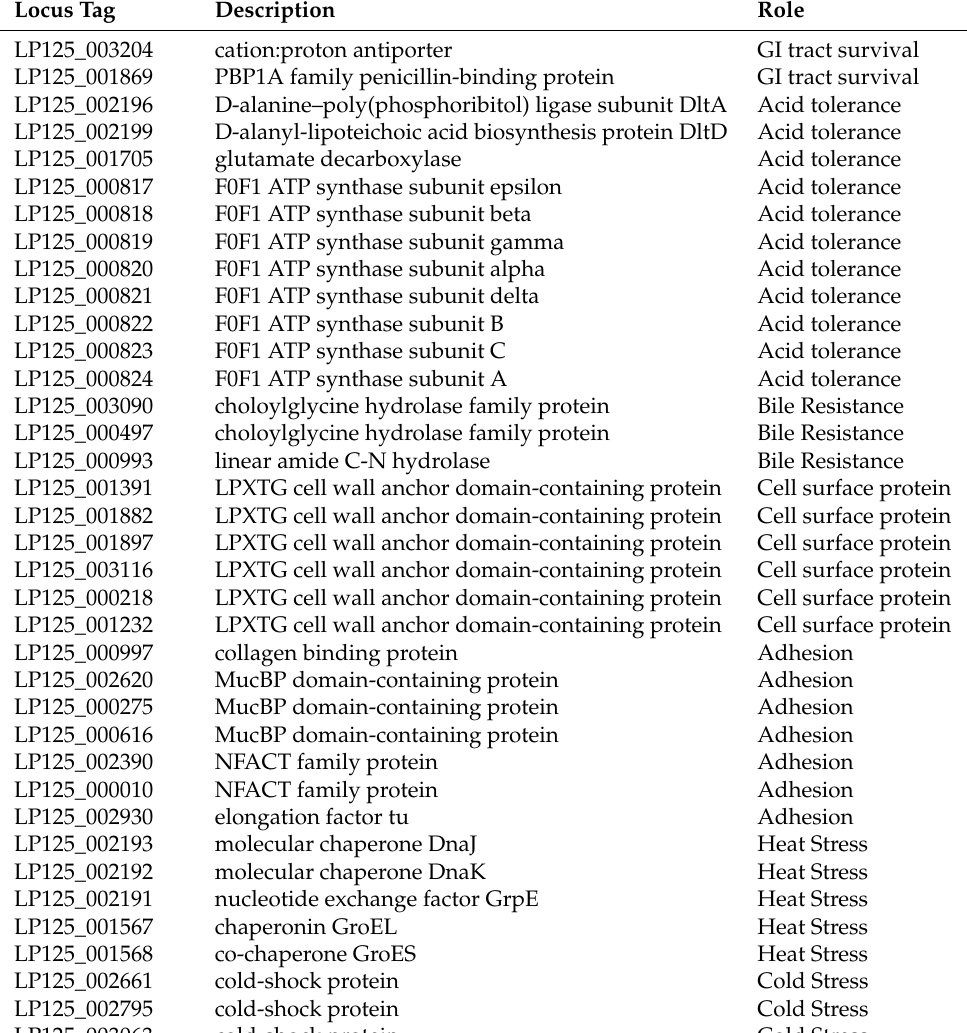
Table 2. List of proteins encoded by L. plantarum L125, involved in stress response and host– microbe